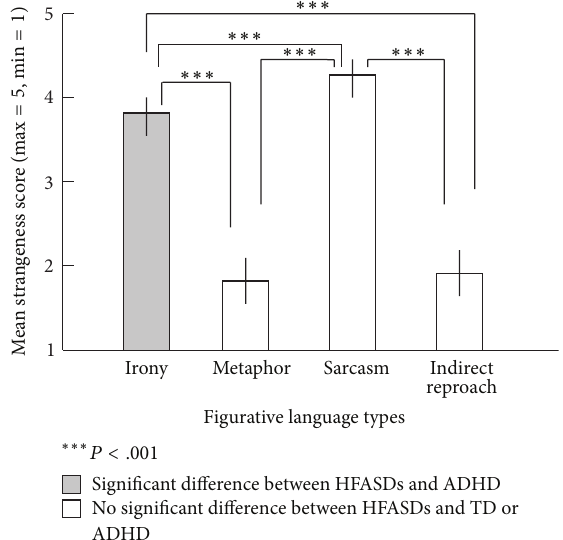
Figure 1: Mean evaluation values of strangeness (unconventional- ity) by college freshmen for each figurative language